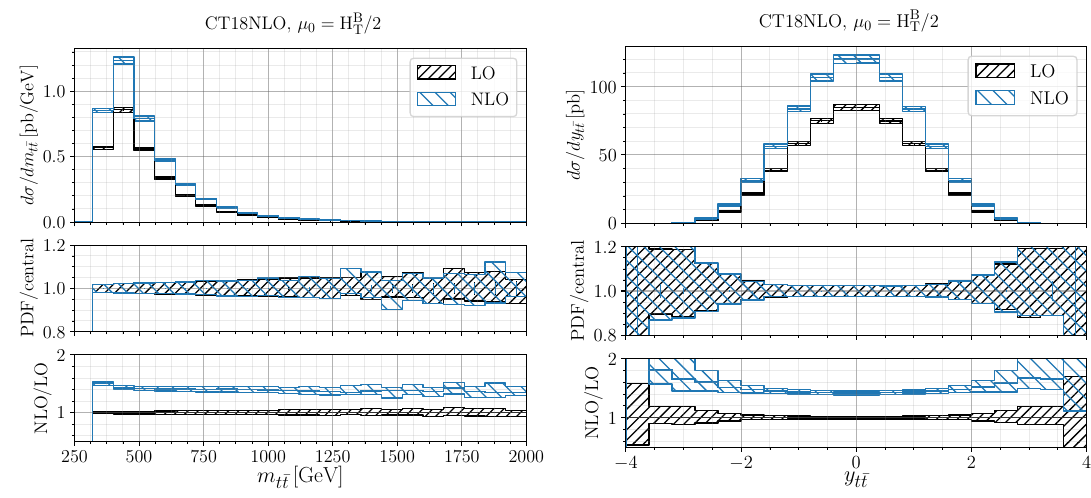
Figure 17 . Central predictions for the p j 1 putation (blue) and in a LO computation (black), using as input in both cases the CT18 NLO PDFs + α s ( M Z ) value, two-loop evolution of α s and the scale µ 0 = H B computed according to the CT18 prescription and rescaled to the 68% C.L. are also shown.